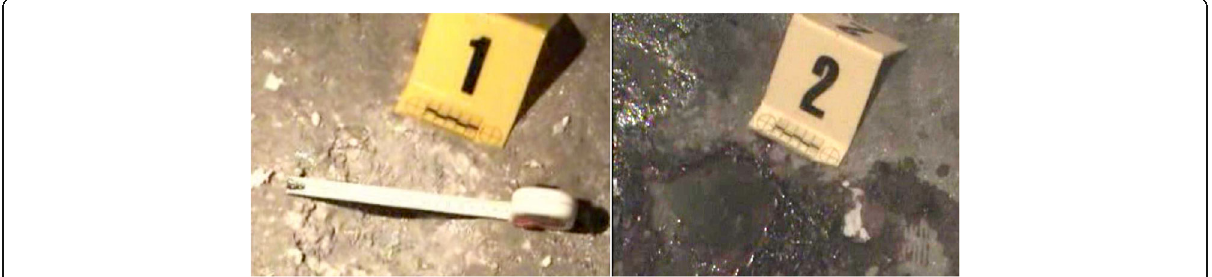
Fig. 4 The explosion seats belong to detonated two DM-41 hand